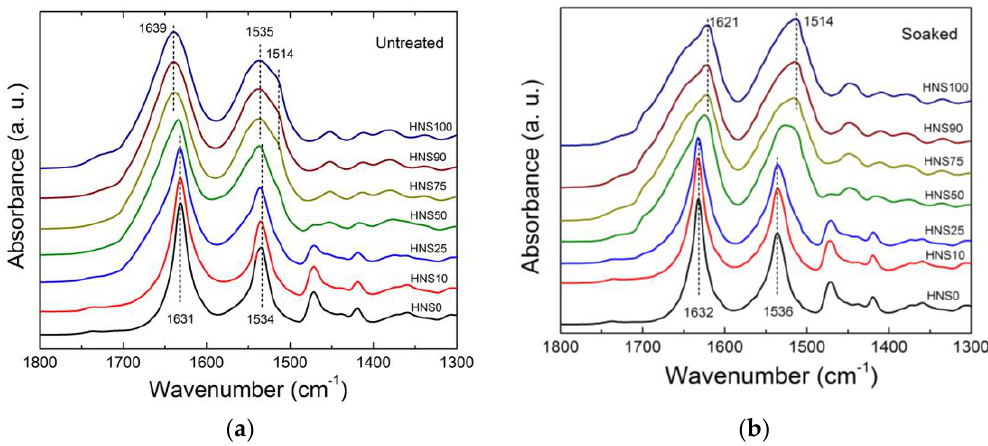
Figure 3. FTIR spectra of nylon1010-silk (HNS) films ( a ) before and ( b ) after water bath treatment.